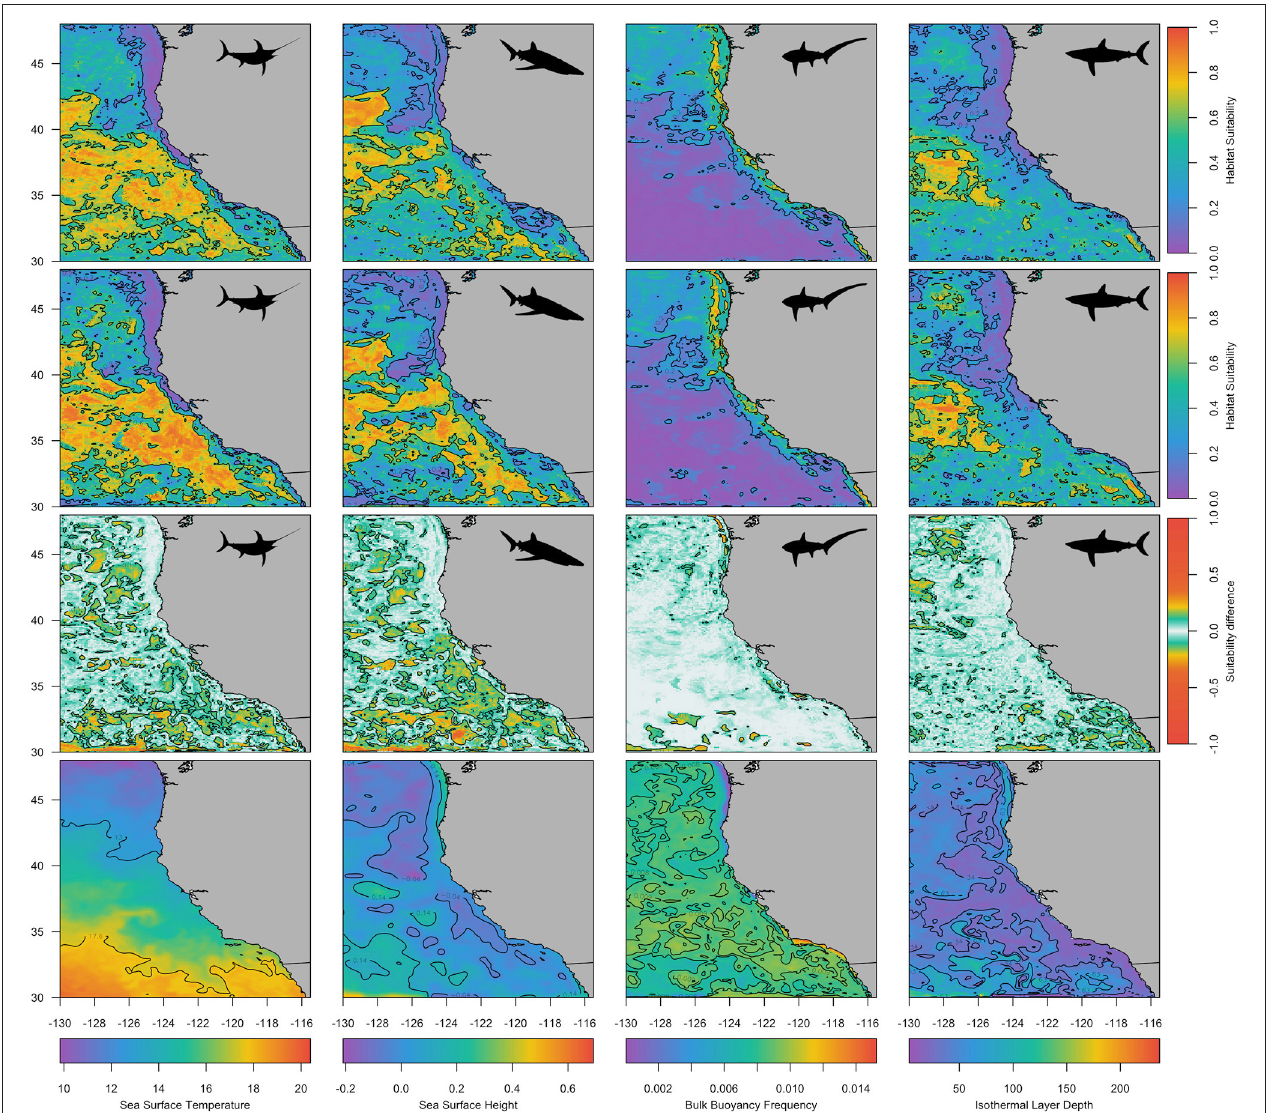
FIGURE 5 | Predicted habitat suitability for each species for an example day, 1 December 2012. The first row shows predicted habitats using simulation 2 (static and dynamic surface variables), the second row shows predicted habitats using simulation 3 (static and dynamic surface and subsurface variables), and the third row shows the difference in probabilities between simulations 2 and 3. The fourth row shows four example dynamic variables for the same day (Sea Surface Temperature, Sea Surface Height, Bulk Buoyancy Frequency, and Isothermal Layer Depth). Species are indicated by a black silhouette: swordfish (first column), blue sharks (second column), common thresher sharks (third column), and shortfin mako sharks (fourth column). Contours on the first and second row are at 0.6 and 0.2, contours on the third row are at 0.1 and − 0.1, and contours on the fourth row equate to the 25 and 75%